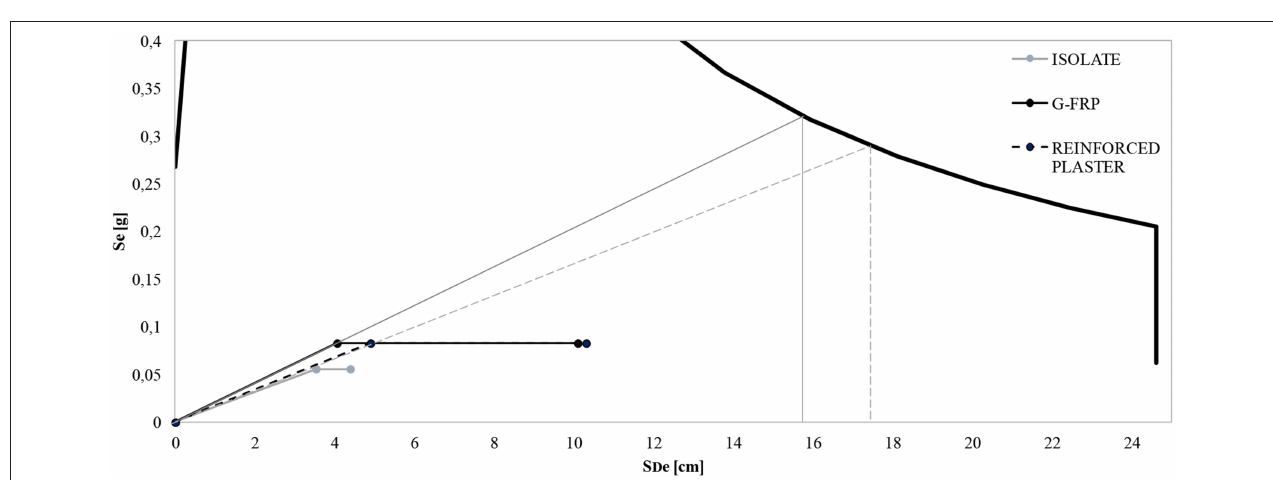
FIGURE 10 | Comparison between capacity curves of the isolate bell tower in the ADRS format before and after retrofitting